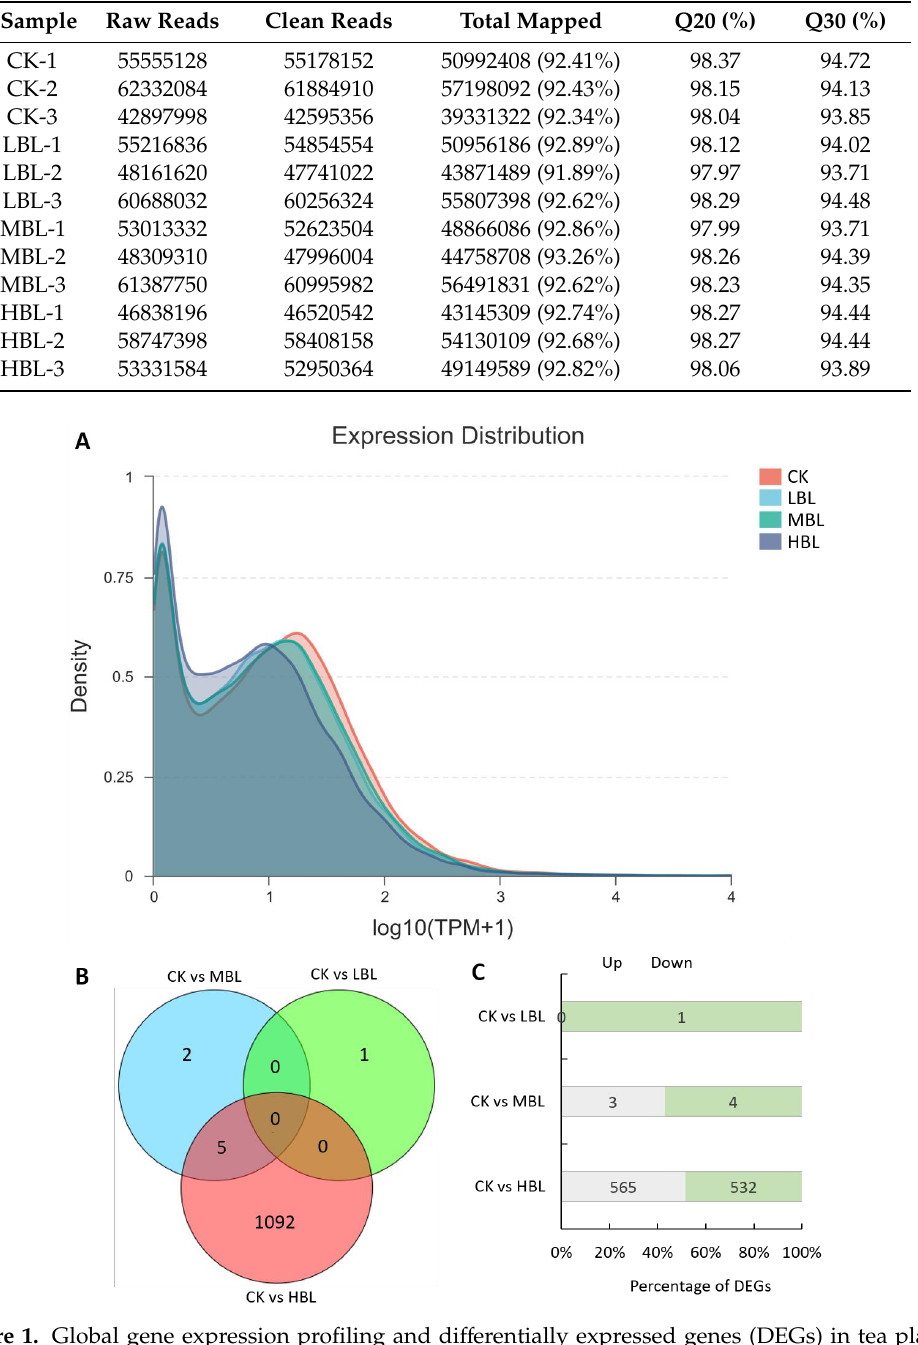
Figure 1. Global gene expression profiling and di ff erentially expressed genes (DEGs) in tea plant shoots under di ff erent blue light intensities. ( A ) Density plot of global gene expression in tea plants under di ff erent blue light intensities. ( B ) Venn diagram of DEGs in tea plants under di ff erent blue light intensities. ( C ) The number of up- and downregulated DEGs in each